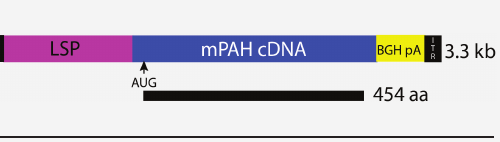
Figure 3. Representative recombinant AAV vector genome for liver-directed gene therapy for PKU. Diagram of a typical recombi- nant AAV vector genome designed for liver-directed gene therapy in Pah enu2/enu2 mice. Expression from the murine PAH complementary cDNA (cDNA) is driven by a strong Liver Specifi c Promoter (LSP). A canonical polyadenylation signal from the bovine growth hormone gene (BGH pA) is also required for appropriate expression. The only viral sequences retained the in genome are the two AAV intermedi- ate terminal repeats (ITRs) fl anking the expression cassette; these sequences are necessary for packaging of the genome into viral capsid proteins to form infectious viral particles and for the ap- propriate intracellular processing of the genomes following vector administration. The translation start site (AUG) is depicted at the 5’ end of the cDNA; translation initiated here yields a functional 454 amino acid PAH monomer that then spontaneously forms enzymati- cally active